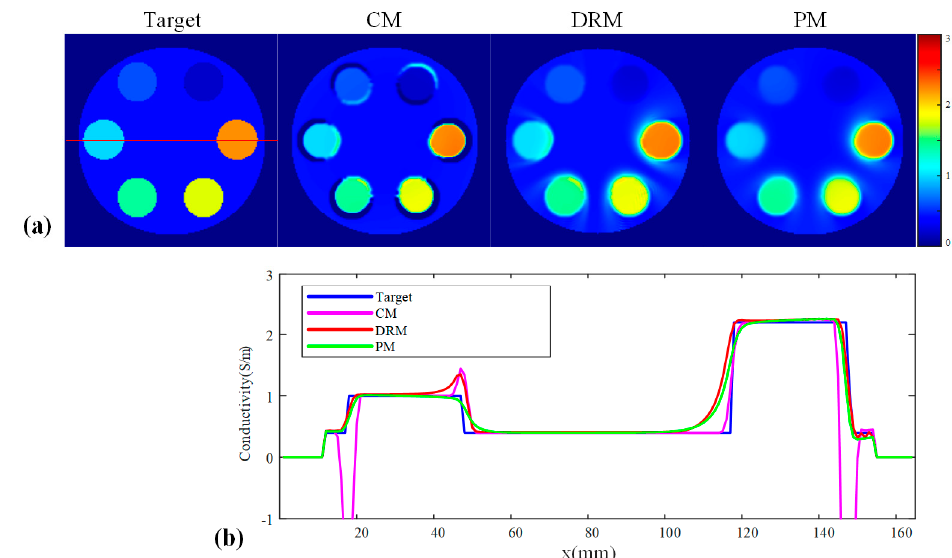
Figure 2. Comparison of reconstructed conductivity images using different methods under the noise-free condition. ( a ) The target image and reconstructed conductivity images using the conventional method (CM), double regularization method (DRM), and proposed method (PM). ( b ) The reconstructed conductivity profiles along the red line in the target image in ( a ).